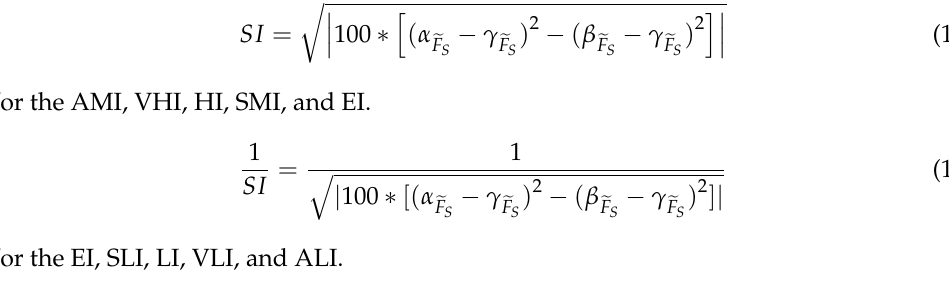
Table 2. SF-AHP linguistic scales used for the pairwise comparisons [72]. Linguistics Scale Fuzzy Number ( α , β , γ ) Score Index (SI) Absolutely high importance (AMI) Very high importance